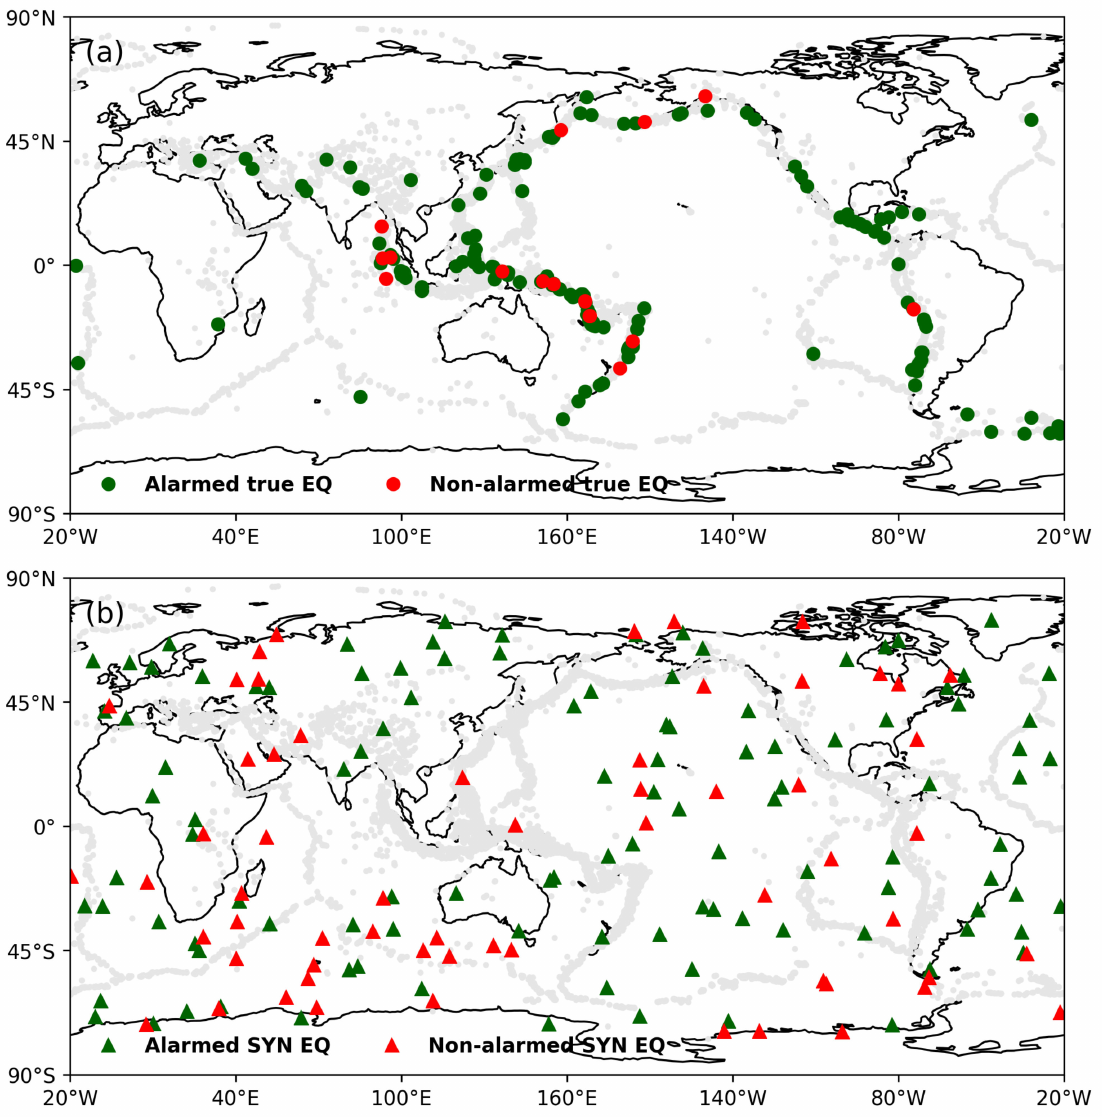
Figure 10. Map of alarmed (temporal integrated anomaly [TIA] counts ≥ 2) and not alarmed earthquakes for both ( a ) true and ( b ) synthetic (SYN)